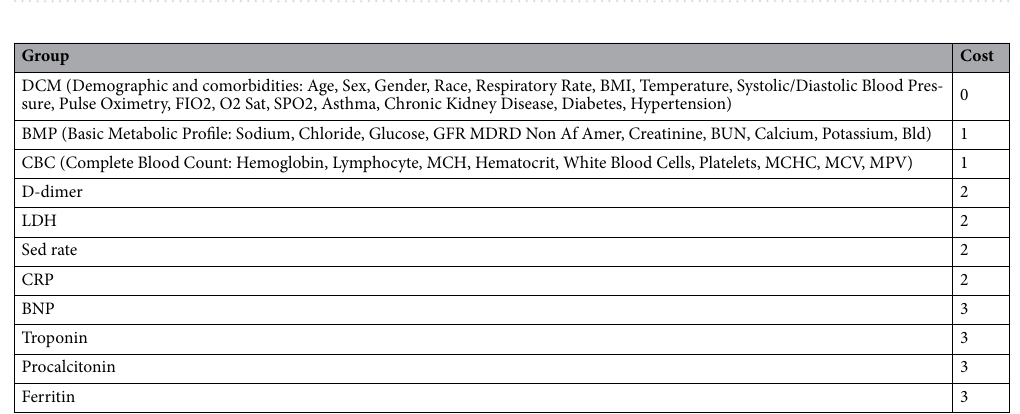
Table 3. Cost structure of clinical features. Pre-defined cost structure for each group of features (may be modified based on the healthcare facility) based on a relative cost score where 0 indicates clinical features that are least expensive and 3 indicates clinical features that are most expensive.